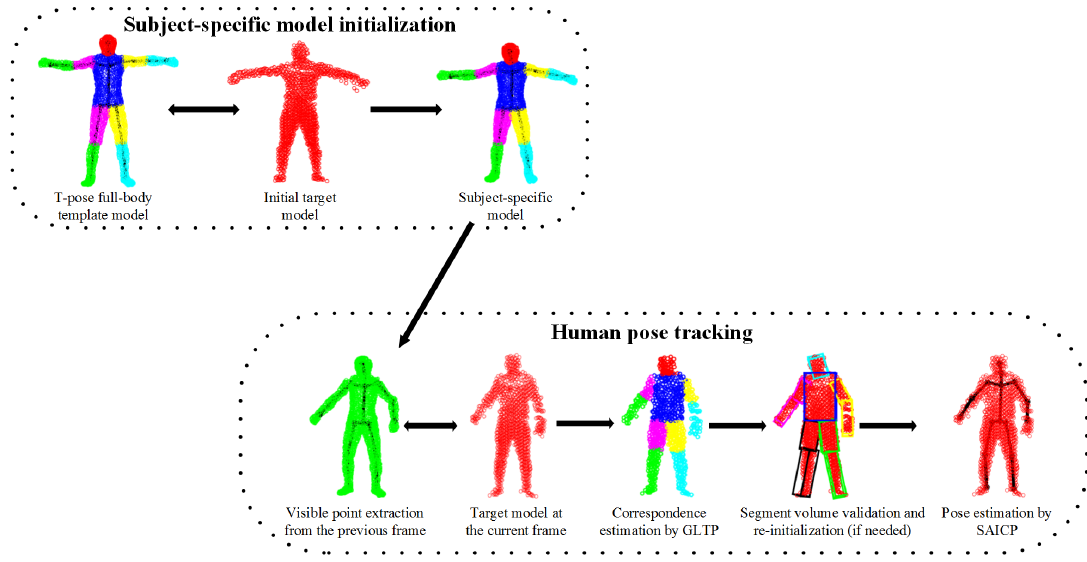
Figure 2. Overview of the proposed human pose tracking